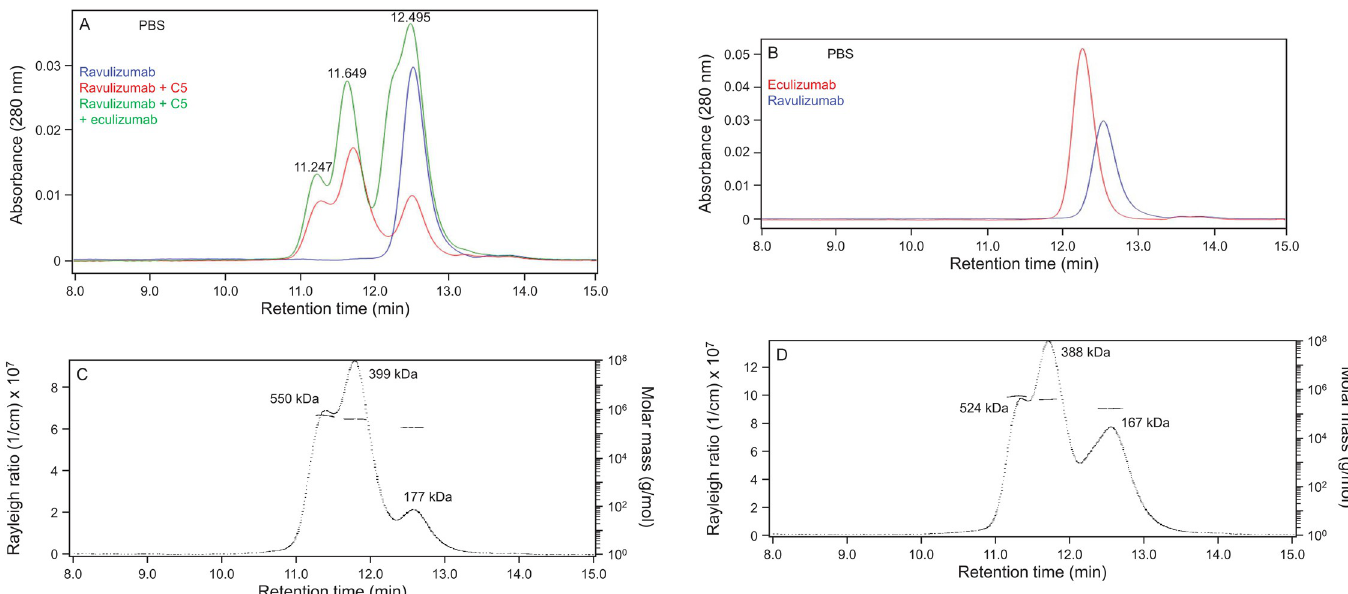
Fig 5. Ravulizumab forms only 1:1 and 1:2 complexes with C5 both in the absence and presence of eculizumab. (A) Ravulizumab alone (700 nM) migrated as a single peak but, in the presence of C5 (400 nM) or C5 (400 nM) plus eculizumab (700 nM), two additional early-eluting peaks were also observed. The last peak to elute in the composition of C5 plus eculizumab and ravulizumab in the region where free antibody elutes exhibited a shoulder. (B) Elution of free eculizumab and ravulizumab had slightly different retention times, explaining the shoulder in Fig 5A. (C) Rayleigh ratios and molar masses of complexes formed between ravulizumab (700 nM) and C5 (400 nM) in PBS. (D) Rayleigh ratios and molar masses of complexes formed in compositions comprising ravulizumab (700 nM), C5 (400 nM), and eculizumab (700 nM) in PBS. Abbreviations: C5 = complement component 5; PBS = phosphate-buffered saline.